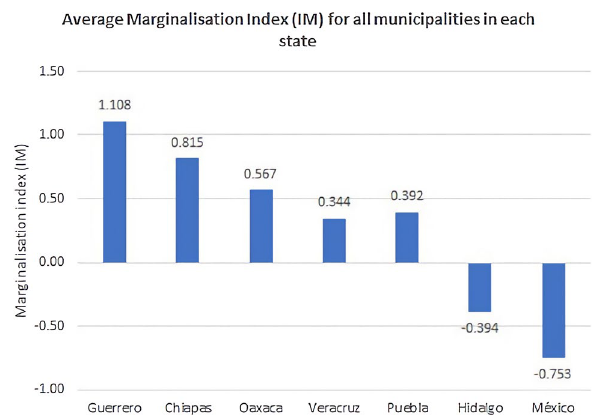
Fig. 13 Average Marginalisa- tion Index (IM) for all